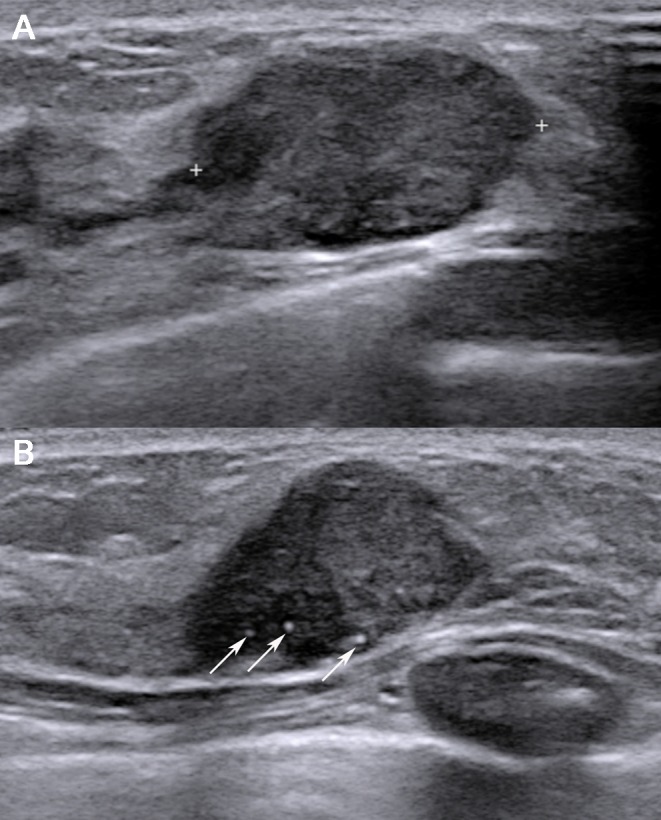
A 38-year-old woman with a recurrence score of 34 (i.e., high risk).US images (A and B) showing an oval-shaped hypoechoic mass with parallel orientation, circumscribed margins, and calcification in the mass (tumour roundness score = 57.45). Surgery confirmed invasive ductal carcinoma with lymphovascular invasion. The immunohistochemistry tests demonstrated PR negativity, HER2 negativity, and a Ki-67 index of 15%.